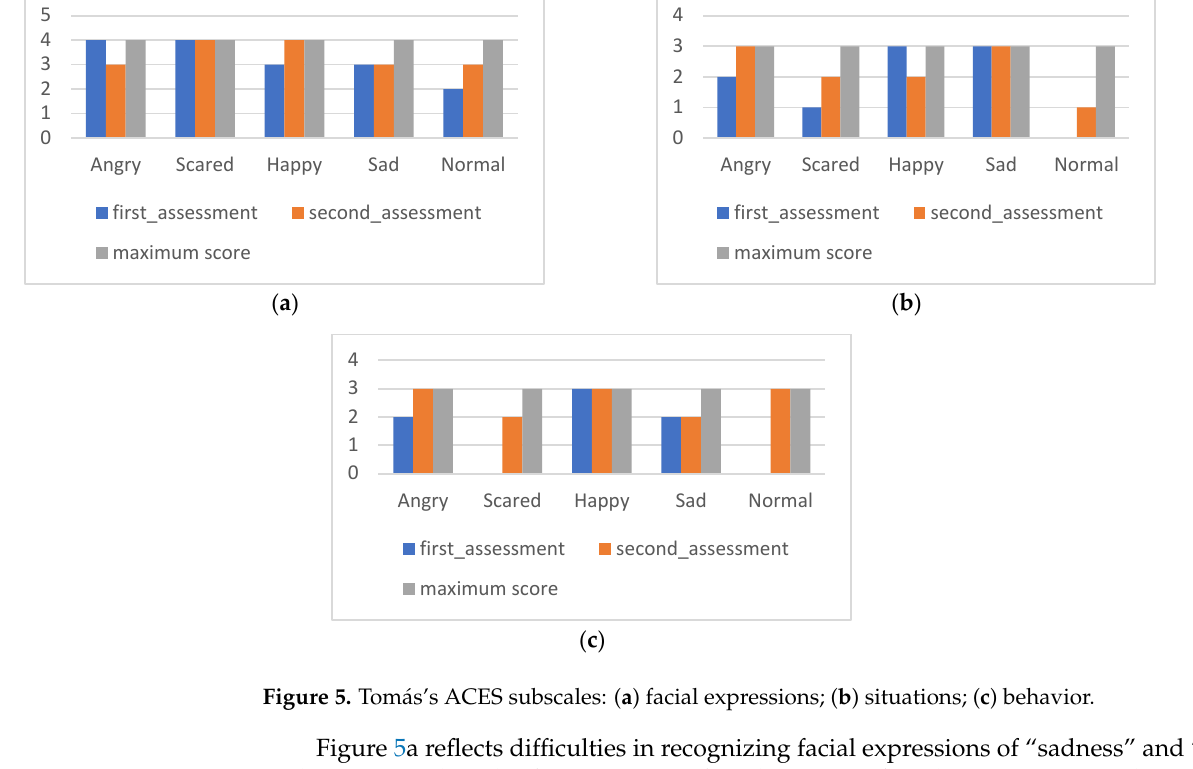
Figure 6 allows an overview of Tomas ’ performance, reflecting a positive evolution in correct emotional perception.